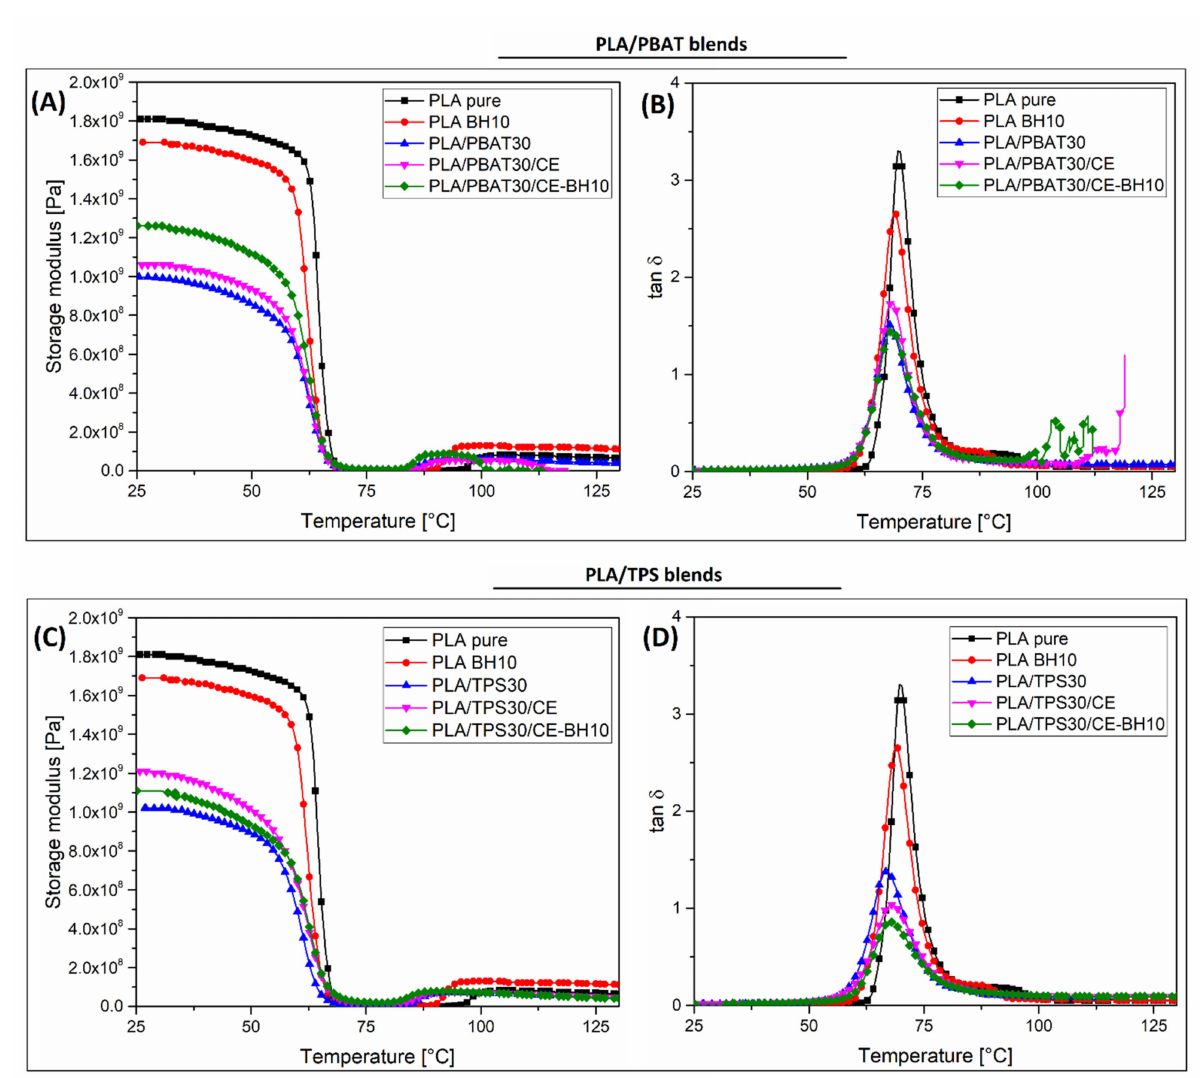
Figure 11. The DMTA thermograms obtained for the FDM-printed samples: ( A , B ) storage modulus and tan δ plots for PLA/PBAT-based samples, and ( C , D ) results for the PLA/TPS-based